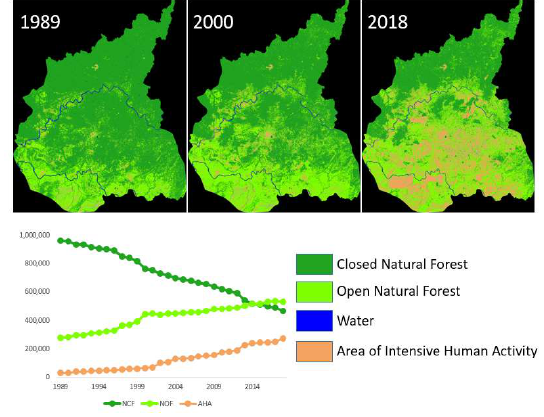
Figure 7. 30-year change of natural forests in Ratanakiri province of Cambodia. Three classified images in upper part of the figure show land cover maps in years 1989, 2000 and 2018. Graph in lower part visualizes quantitative changes closed and open natural forest and area of intense human activities.